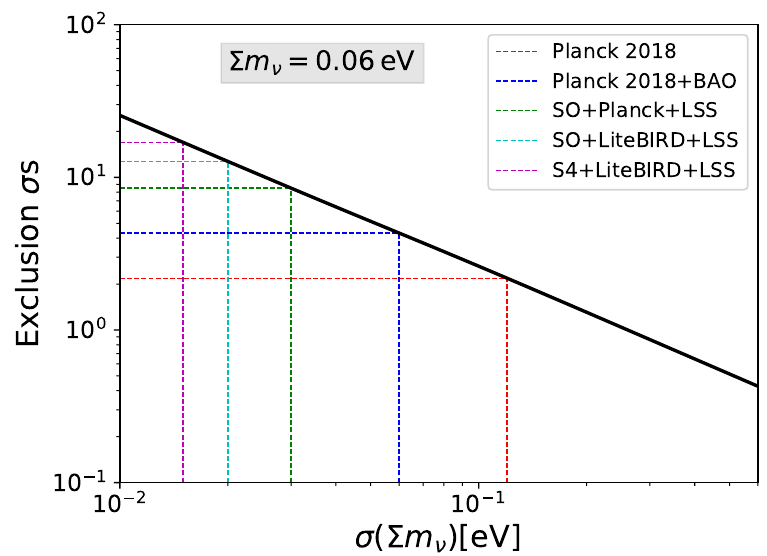
Figure 5 . Preference for hierarchical over quasi-degenerate neutrinos, expressed in terms of Gaus- sian (cid:27) ’s, versus the sensitivity (cid:27) ( P m (cid:23) ) to the sum of neutrino masses. The dashed lines correspond to the combinations of current and future experiments discussed in the text. The plot assumes the minimal value P m (cid:23) = 60 meV allowed by neutrino oscillation experiments for NO. This value yields the highest statistical signi(cid:12)cance with which one would be able to rule out quasi-degeneracy. masses are computed as described in section 3.2. Note that m depends also on (cid:12)(cid:12)